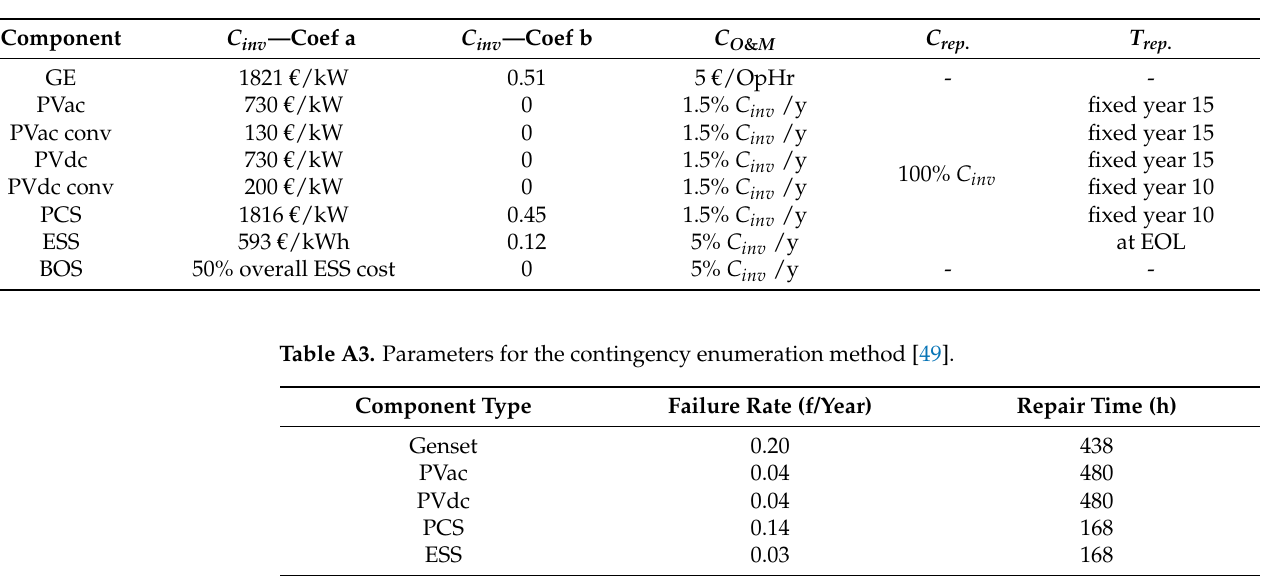
Table A2. Economical parameters of the optimization method.